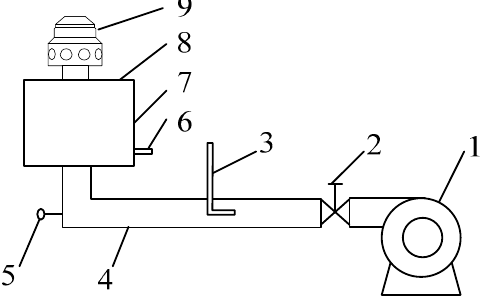
Figure 1. Schematic diagram of cold-state experiment rig. 1—fan; 2—air flow regulating device; 3—air flow speed measuring device; 4—air duct; 5—temperature measuring device; 6—air pressure measuring device; 7—wind box; 8—distributor; 9—air nozzle.